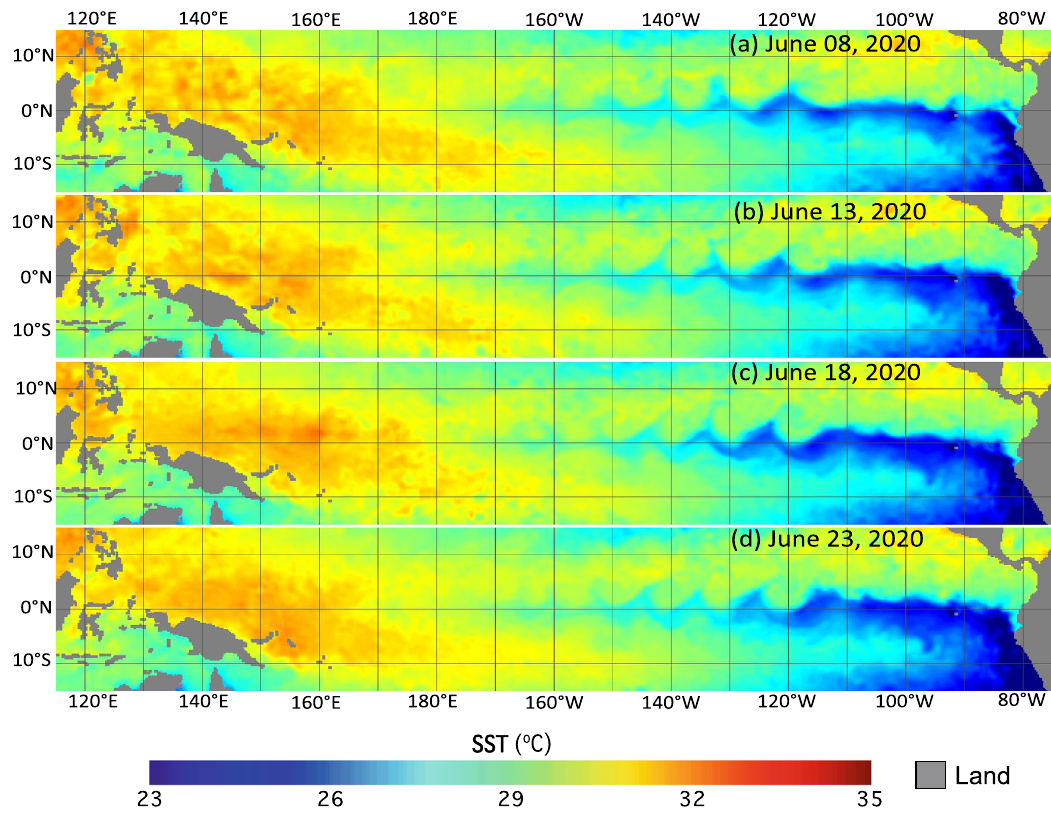
Figure 1. Satellite-measured SST in the Equatorial Pacific Ocean on ( a ) June 8, 2020, ( b ) June 13, 2020, ( c ) June 18, 2020, and ( d ) June 23,